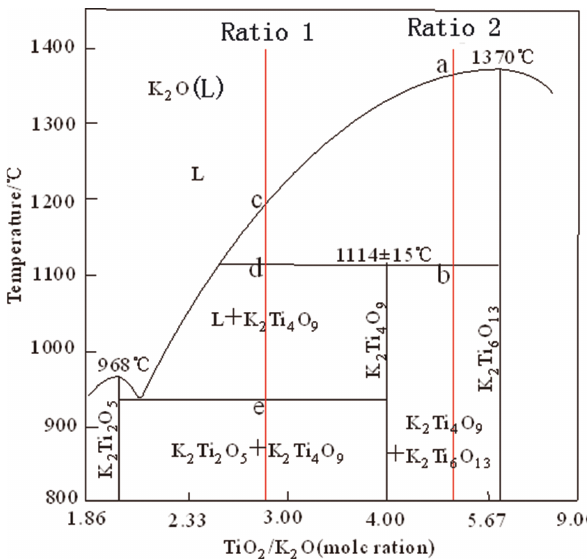
Figure 1: Phase diagram of TiO 2 – K 2 O system.